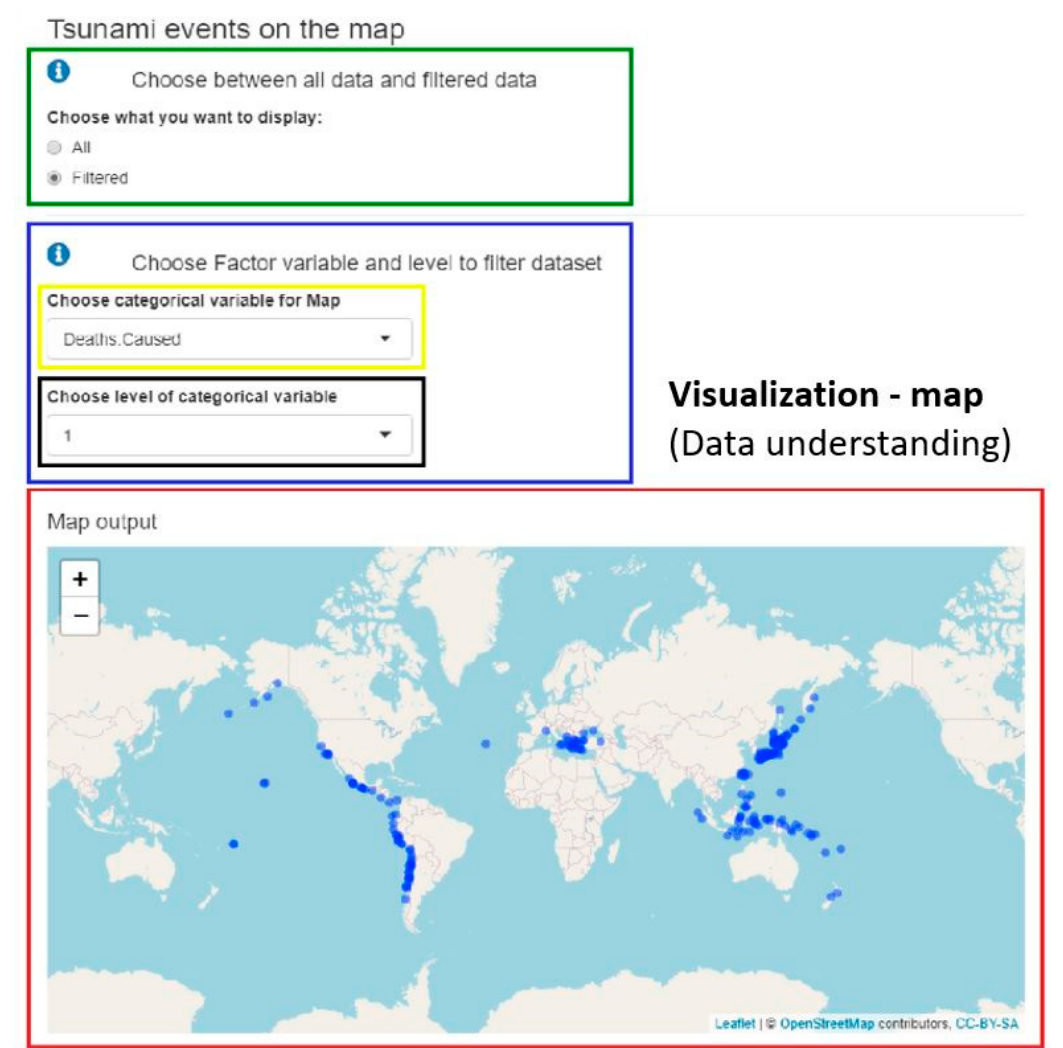
Figure 6. Data visualisation with a map: tsunami events on the map (data understanding).